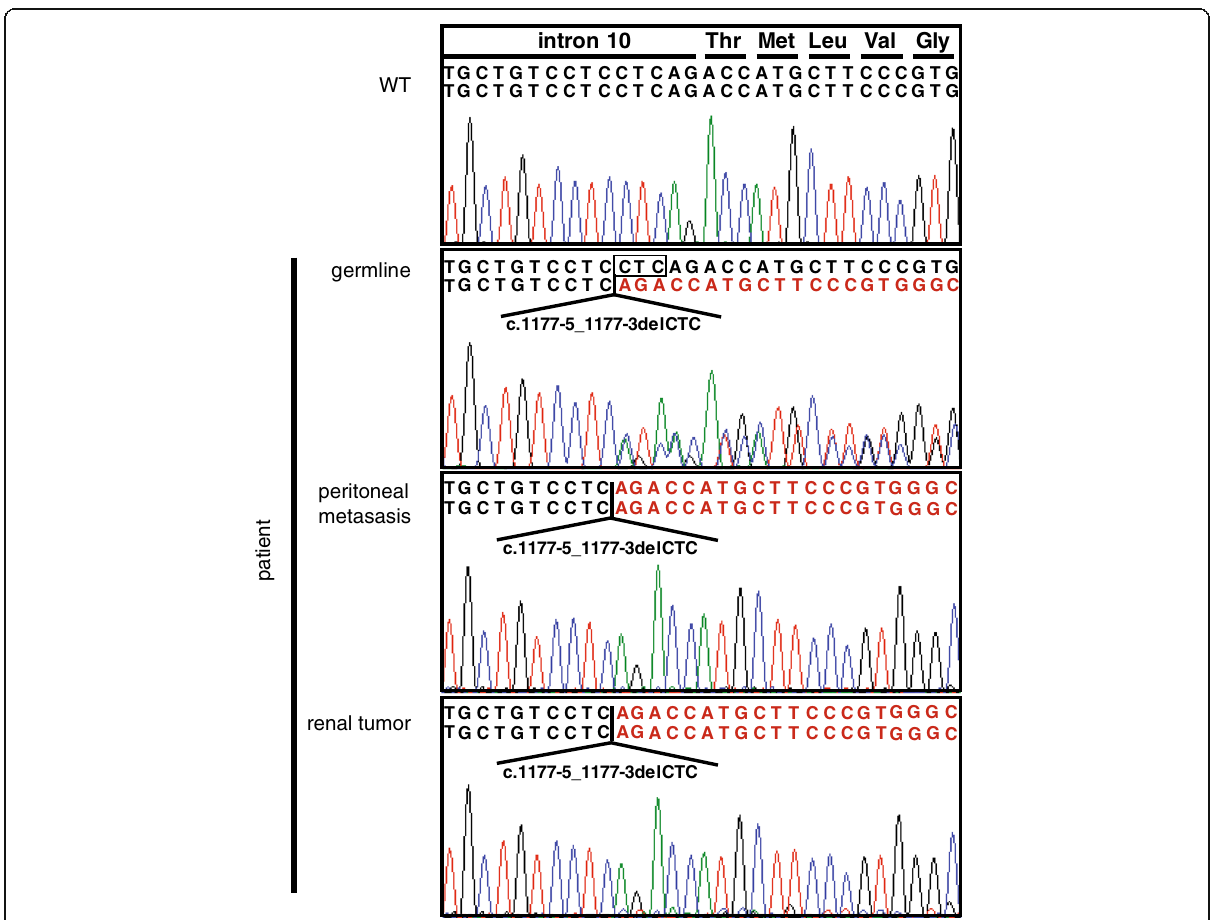
Fig. 2 Sanger sequencing of lymphocyte DNA of the patient reveal a heterozygous three nucleotide deletion in an intron right upstream of exon 11 (c.1177-5_1177-3). The same mutation was found in homozygous state when the renal tumor or the peritoneal metastasis was